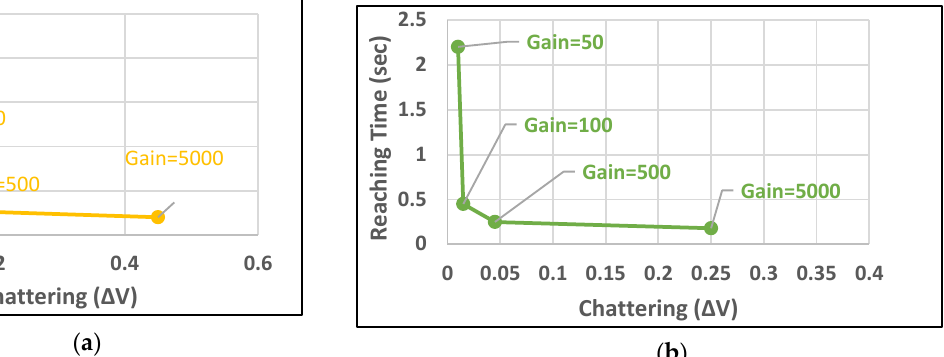
( d ) Figure 5. Trade-off between reaching time and chattering on different gain values: ( a ) PRERL [27], ( b ) RRL [29], ( c ) EERL [24], ( d ) proposed C-ERL-RSS. 4. SMC with Proposed Reaching Law Relation of the first derivative of the sliding surface, shown in (15), can also be rep- resented as: 𝑆̇ = 𝑒 1 ̇ 𝜆 + 𝑒 2 ̇ = 𝑒 1 ̇ 𝜆 + 𝑒 1 ̈